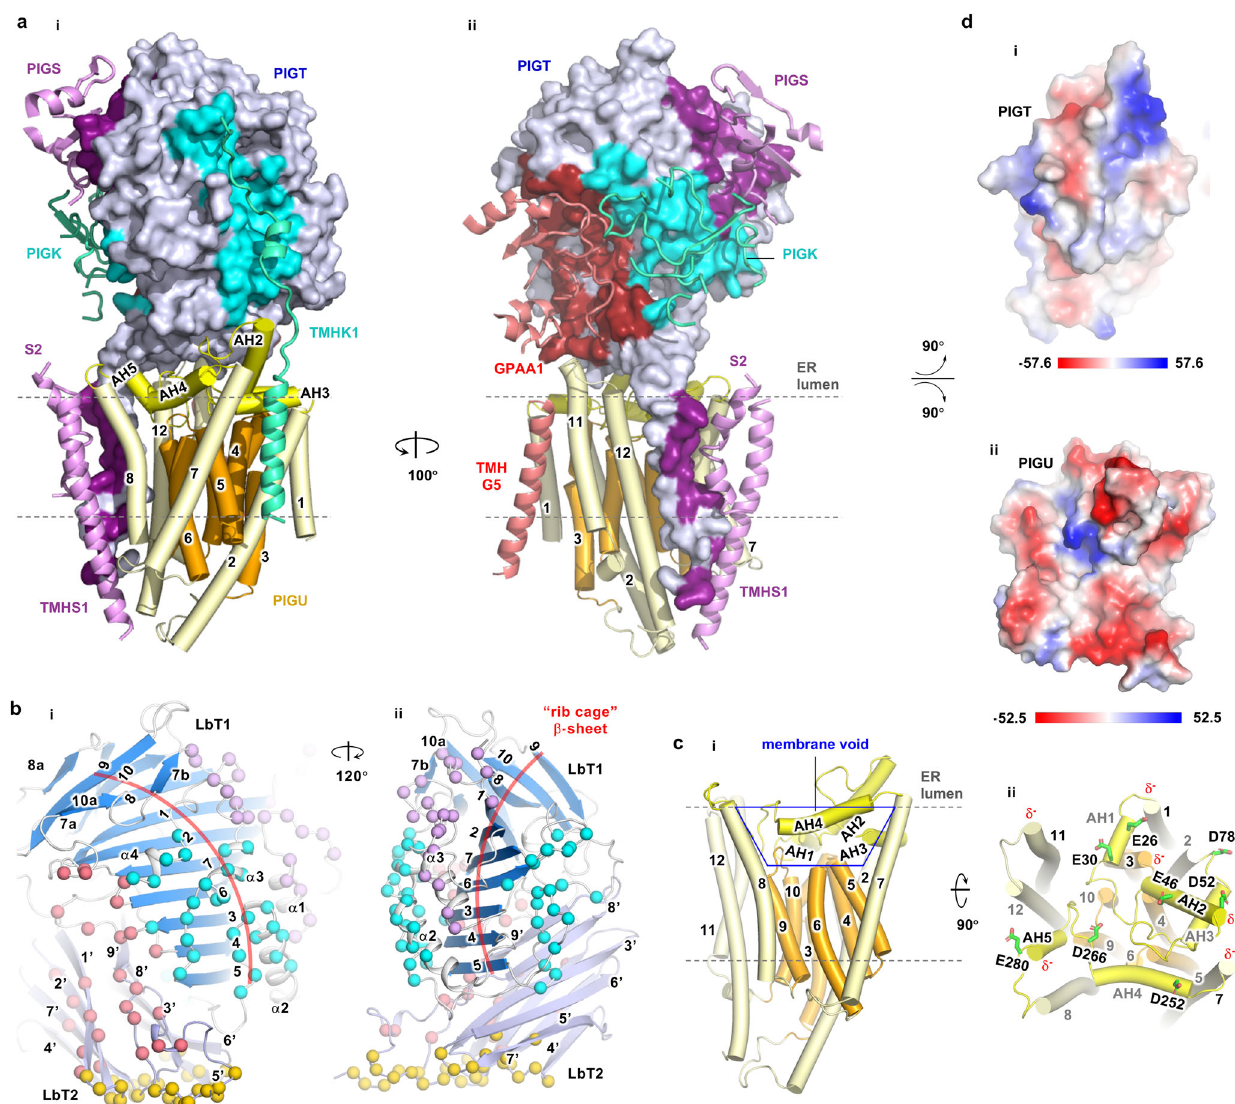
Fig. 4 PIGT and PIGU form a platform for complex assembly. a PIGT (surface representations, blue) and PIGU (cylinder, yellow/orange) form a docking platform for other subunits (GPAA1, red; PIGS, purple; PIGK, cyan, ribbon). Interaction surfaces on PIGT are shaded to match the color of GPAA1/PIGK/ PIGS. b PIGT displays skeleton features. Its luminal domain contains two lobes (LbT1/2). LbT1 (marine) consists of a central “ rib-cage ” β -sheet (red curve, β 1-10) sandwiched by connecting loops, α -helices ( α 1-4), and β -strands ( β 7a, 7b, 8a, and 10a). LbT2 (light blue) consists of two layers of β -sheets with a total of 9 β -strands ( β 1 ′ -9 ′ ). Spheres indicate residues that interact with GPAA1 (red), PIGK (cyan), PIGS (purple), and PIGU (orange). c Side ( i ) and normal ( ii ) view of PIGU. PIGU features a membrane core region (orange) with short transmembrane helices (TMHs) enclosed by a ring of TMHs (pale yellow). This arrangement creates a membrane void (blue trapezoid) to hold the fi ve amphipathic helixes (AH) 1-5 (yellow). The TMHs and AHs are so arranged such that the C-terminal ends of several α -helices (labeled with black text) expose to the surface (ii). The resulting dipole moments ( δ - ) and acidic residues (stick representation, green) make the surface electrostatically negative. d “ Open-book ” representation of the electrostatic potential molecular surface (red, negative; blue, positive; white, neutral) generated using the Adaptive Poisson-Boltzmann Solver module in PyMOL (version